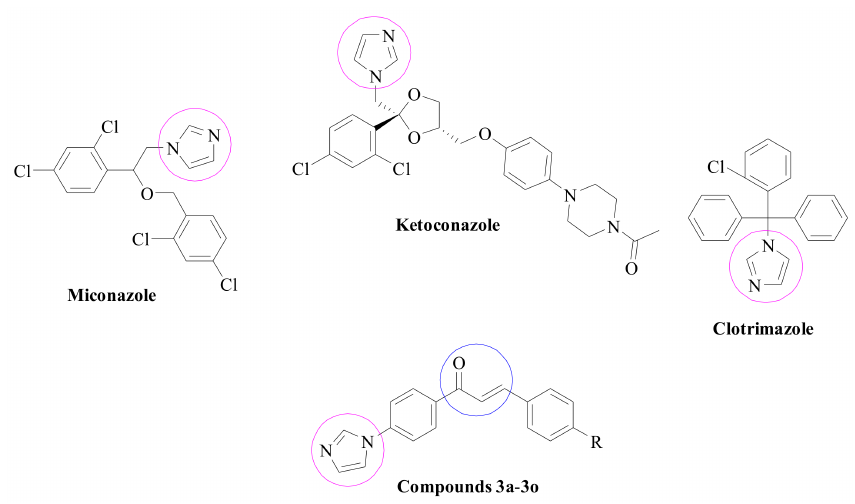
Figure 1. Structures of some antifungal agents and synthesized compounds ( 3a – 3o